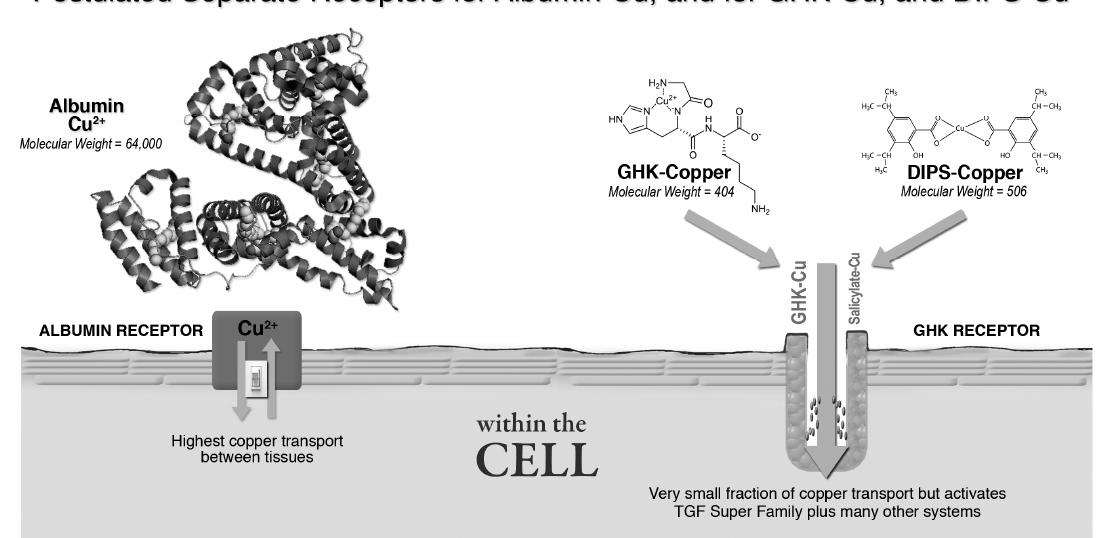
Figure 3. Proposed cell receptor for GHK-Cu.